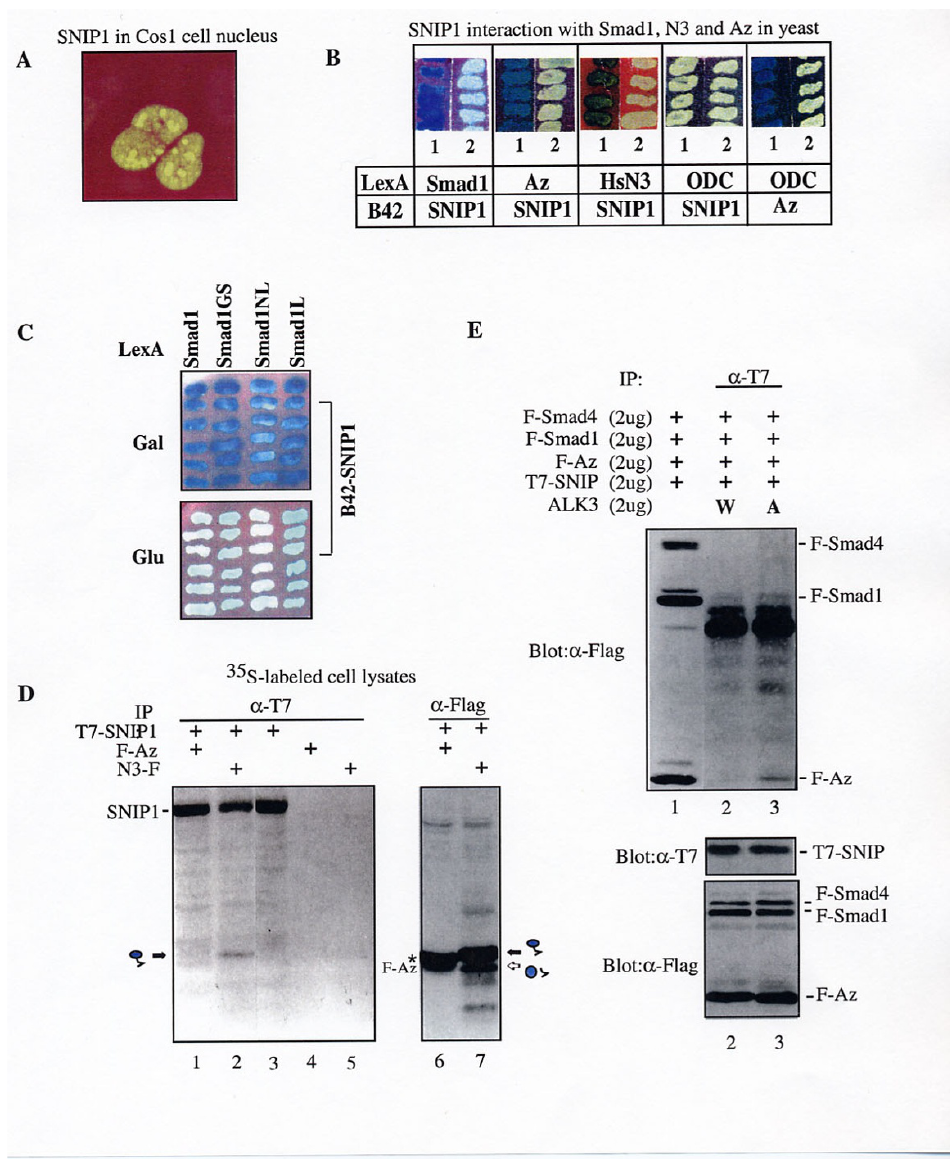
Figure 7 A novel Smad1 Nuclear Interacting Protein (SNIP1) is recruited to interact with Az in a BMP receptor activa- tion-dependent fashion.A. SNIP1 is a nuclear protein. COS1 cells were transfected with T7-tagged SNIP1. Anti-T7 mono- clonal antibody and FITC conjugated anti-mouse secondary antibody was used to detect SNIP1. B. SNIP1 specifically interacts with Smad1, Az and HsN3 but not with ODC in the yeast two-hybrid system. The panels labeled as "1" and "2" represent yeast transformants on U - H - W - galactose or glucose plates, respectively. B42 fusion proteins were only induced in yeast grown on galactose plates. C. Domain mapping of Smad1 interaction with SNIP1 in yeast. "Smad1GS" represents the mutant Smad1 (G419S) [40]. Smad1NL contains the MH1 and the linker region; Smad1L contains only the linker region. D. SNIP1 interacts with the pro-sequence-containing form of HsN3 but not with Az in COS cells upon coexpression. COS cells were transfected with the indicated plasmids. Cells were metabolically labeled with 35 S-methionine for the last 4 hours before lysates were made for immunoprecipitation. Az is marked by an asterisk in lane 6, while the two forms of HsN3 are marked as in previous Figures. E. SNIP1 interacts with Az upon its co-expression with Smad1, Smad4 and the BMP type I receptor activation enhances the interaction. COS cells were transfected with 2 µ g each of the indicated plasmids. The anti-T7 immunoprecipitates were ana- lyzed by Western blot with monoclonal anti-Flag (top panel). The co-precipitated F-Az is indicated (lane 3). Protein expression was monitored by Western blot analyses of total lysates as shown in bottom